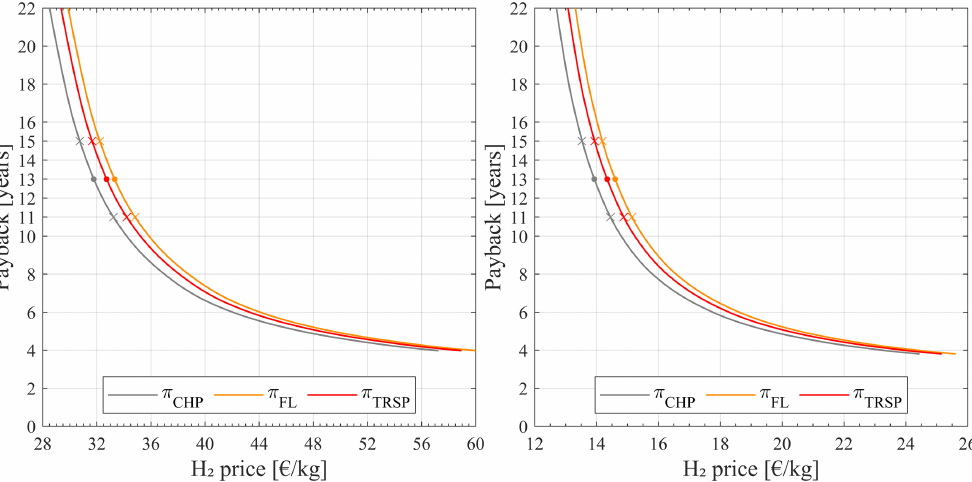
Figure 4. Green scenarios—relation between payback period and H 2 price for each customer for scenario Green17–20 ( left ) and Green21 ( right ).